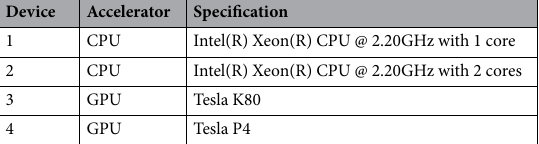
Table 4. The devices inspection used for measuring the prediction speed of the models.